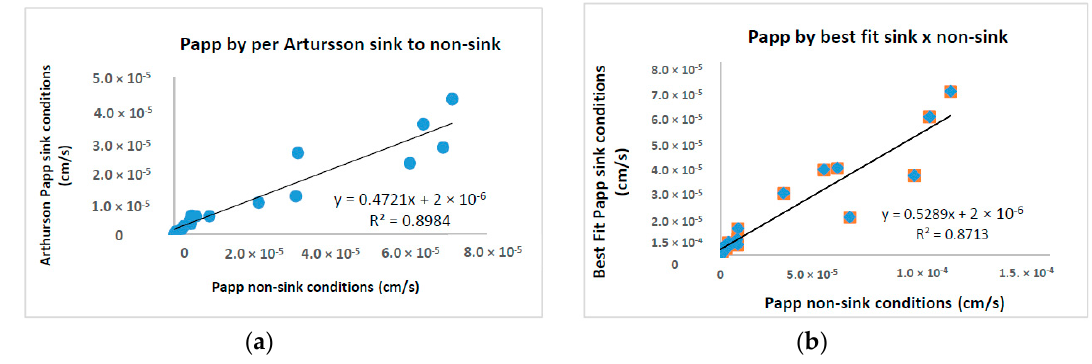
Figure 5. Papp calculations using equations by ( a ) per Artursson non-sink versus sink conditions and, ( b ) per Artursson non-sink compared to sink conditions best fit method of the linear